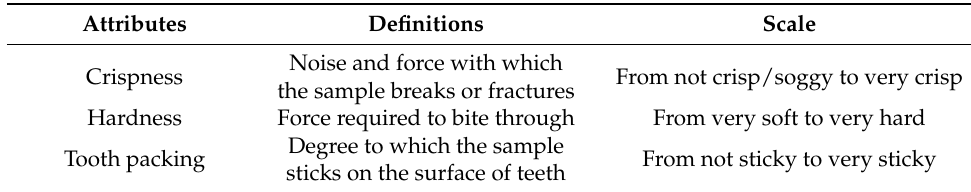
Table 2. List of the sensory attributes, their definitions, and the intensity scales used for profile evaluation of extruded products.